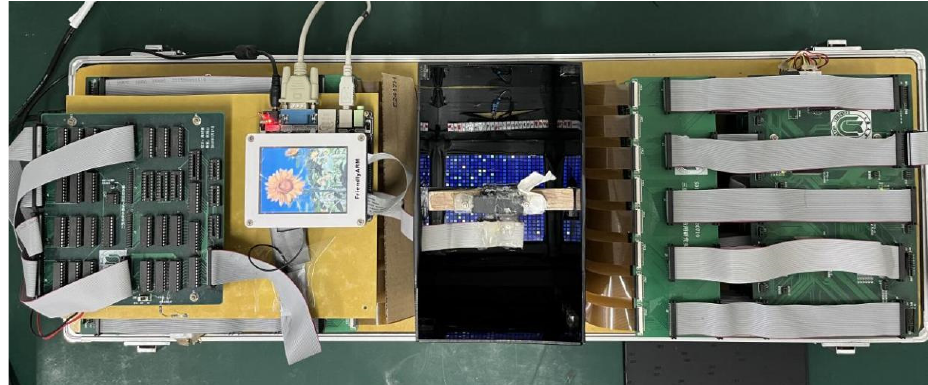
Figure 9. The SD16 system.